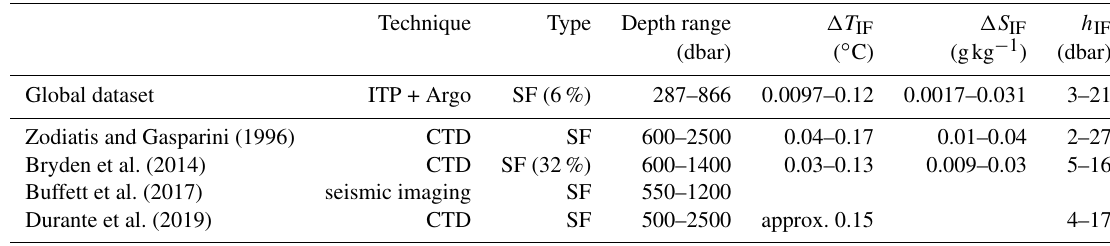
Figure 8. Number of detected interfaces obtained with the detection algorithm for different input parameters. Each panel shows the sensitivity of the detection algorithm to one input parameter: (a) moving average window, (b) density gradient of the mixed layer, (c) density difference within the mixed layer, and (d) the maximum height of the interface. In each panel, the grey histogram corresponds to the default parameters listed in Table 2. The coloured lines correspond to the varying parameter (see legend). Shaded regions indicate Turner angles in the diffusive- convective (blue) and salt-finger (red) regimes. Table 4. As Table 3, but for the Mediterranean Sea (30–43 ◦ N, 0–15 ◦